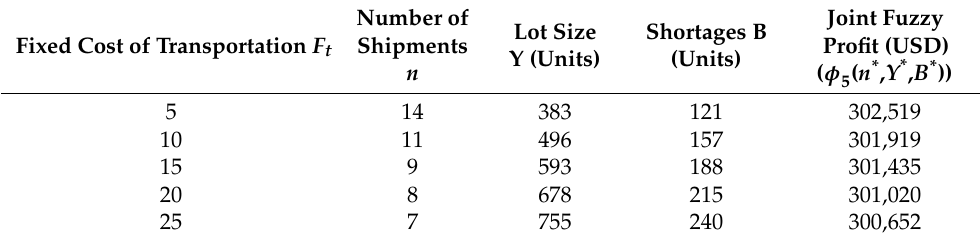
Fixed Cost of Transportation F t